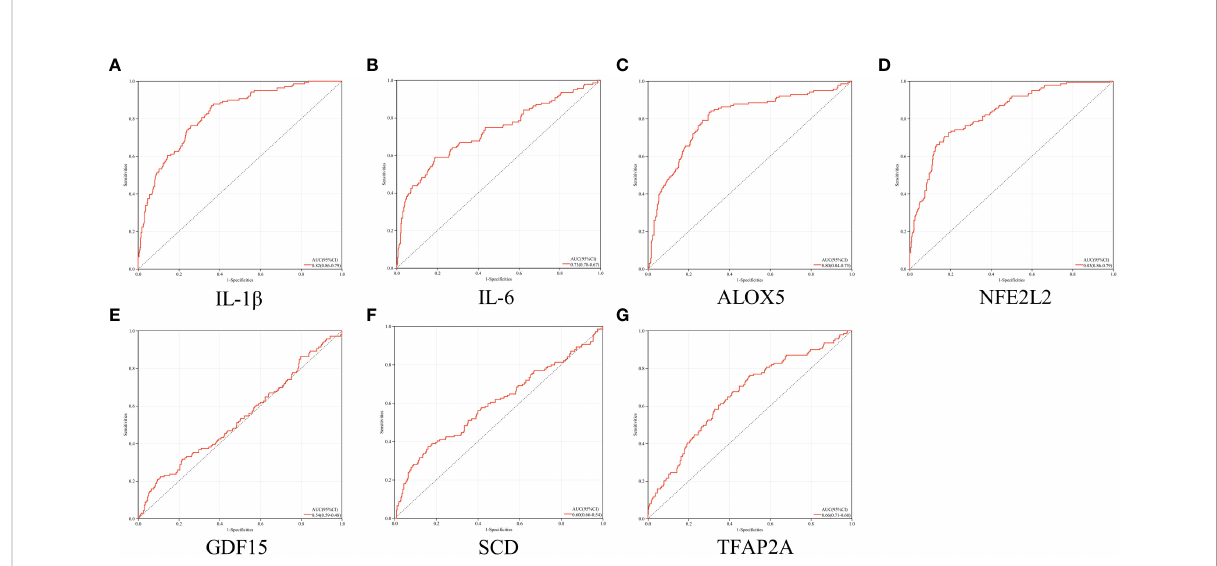
FIGURE 6 ROC analysis. ( A – G ) ROC analysis results of IL-1 b , IL-6, ALOX5, NFE2L2, GDF15, SCD and TFAP2A,